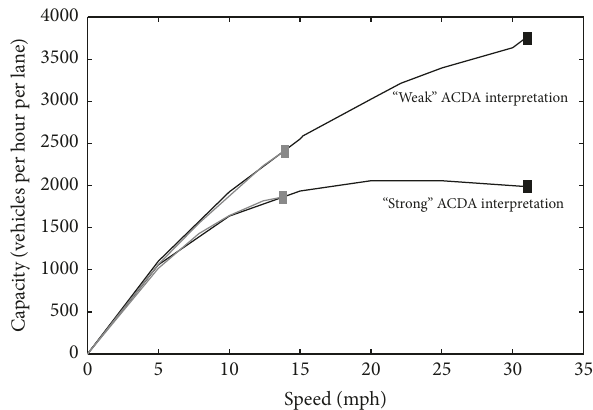
Figure 6: Relationship between speed, turning radius, and through- put (vehicles per hour). Gray and black curves represent 𝑟 = 15 󸀠 and 𝑟 = 75 󸀠 , respectively; square markers indicate V CTF